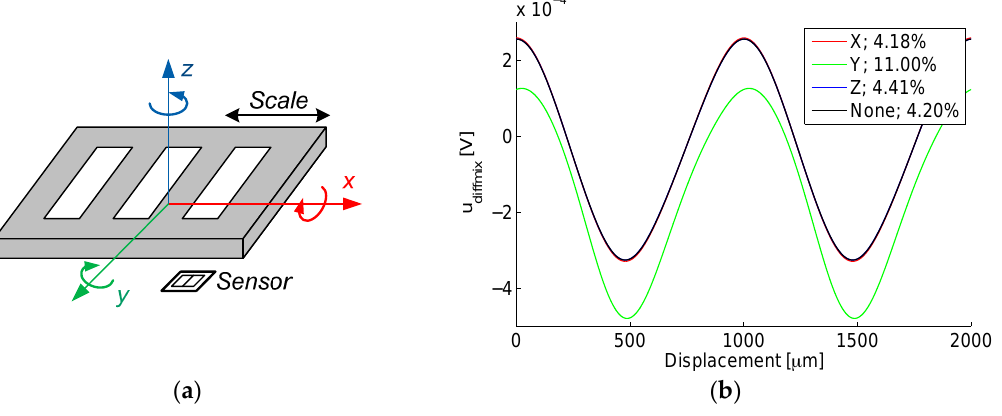
Figure 9. ( a ) The simulated scale rotation (3°) axes shown over the sensor with the microcoils; ( b ) the target rotation simulation results (the demodulated and filtered u diffmix signal). Signal THDs are given in the legend.